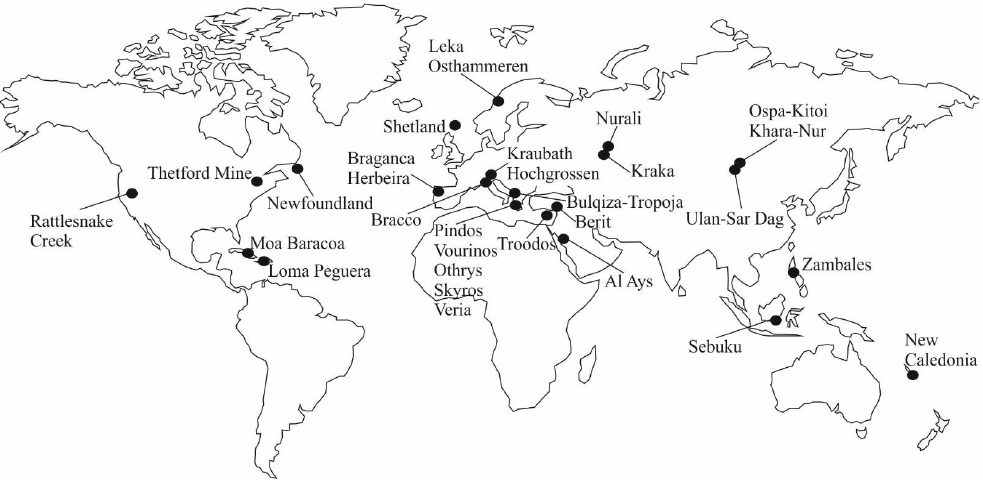
Figure 1. World-wide distribution of the PPGE-PPGM-rich ophiolitic chromitites. Most of the chromitites have been analyzed for the PGE distribution and for the pres- ence of PGM. According to Table 1, PPGE-PPGM-rich chromitites have been reported from 19 countries of the northern hemisphere (Figure 1), except for Indonesia and New Caledonia, which belong to the southern hemisphere. Geochronological data show a var- iation range from Proterozoic to Eocene. On the basis of the ideal stratigraphy of the host ophiolite, the PPGE-PPGM-rich chromitites occur in the mantle, in the mantle transition zone (MTZ) and in the cumulus pile of the crustal sequence (Table 1). From a composi- tional point of view, the ophiolitic chromitites are classified as Cr-rich (Cr# = Cr/(Cr + Al) > 0.7) and Al-rich (Cr# < 0.7) [60]. Considering this classification, the PPGE-PPGM-rich